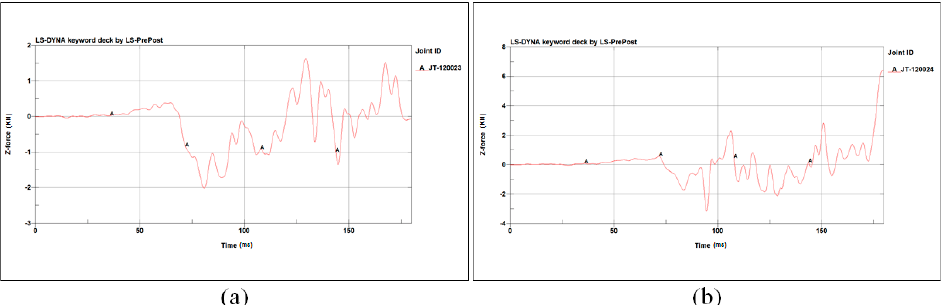
Figure 17. Test 3: Dummy 1’s compressive force (KN) vs. the time (ms) of ( a ) the left femur and ( b ) the right femur.